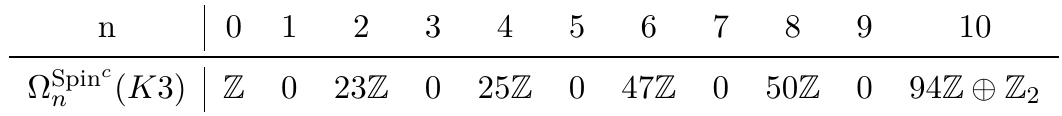
Table 12 . Cobordism groups Ω Spin c